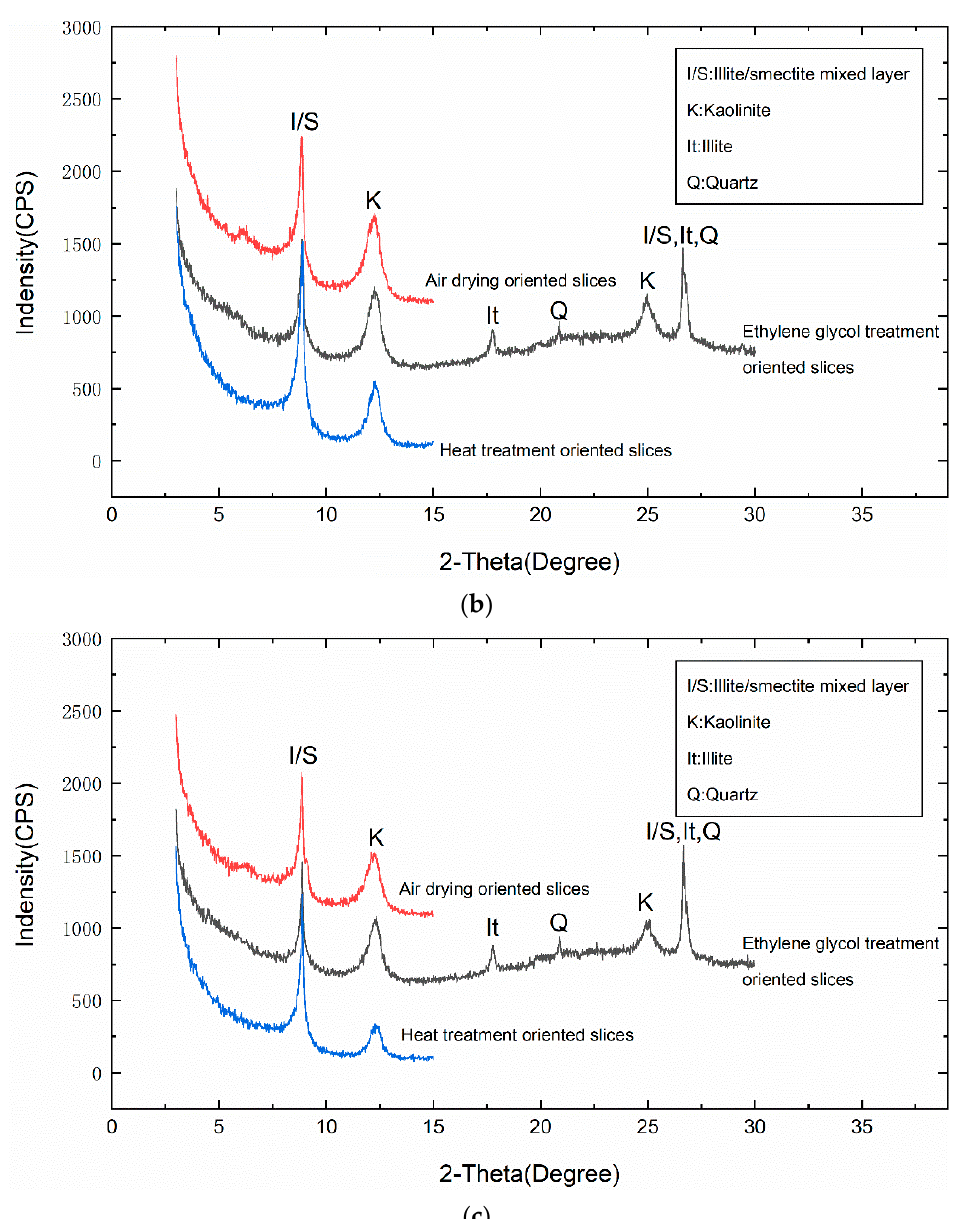
Figure 3. XRD patterns of clay minerals (smectite, kaolinite, illite, and their mixed layer) in specimens at 28 days: ( a ) red clay; ( b ) 15% steel slag; ( c ) 9% cement. Table 3. The relative content of clay minerals in the red clay, steel slag-modified and cement- modified specimens. The Relative Content of Clay Additives